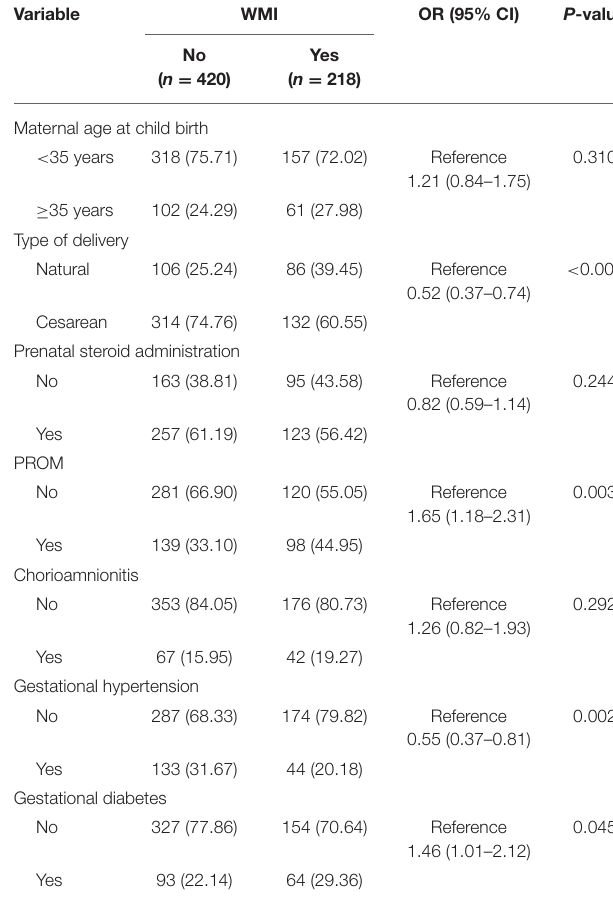
TABLE 1 | Univariate analyses of baseline of premature infants in the case and control groups. Variable